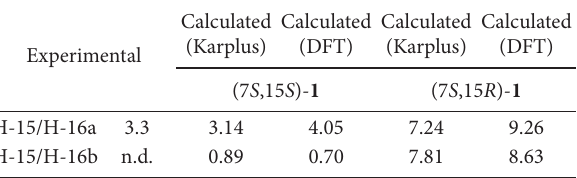
Table 3. Experimental and calculated 3 J HH values (Hz) for